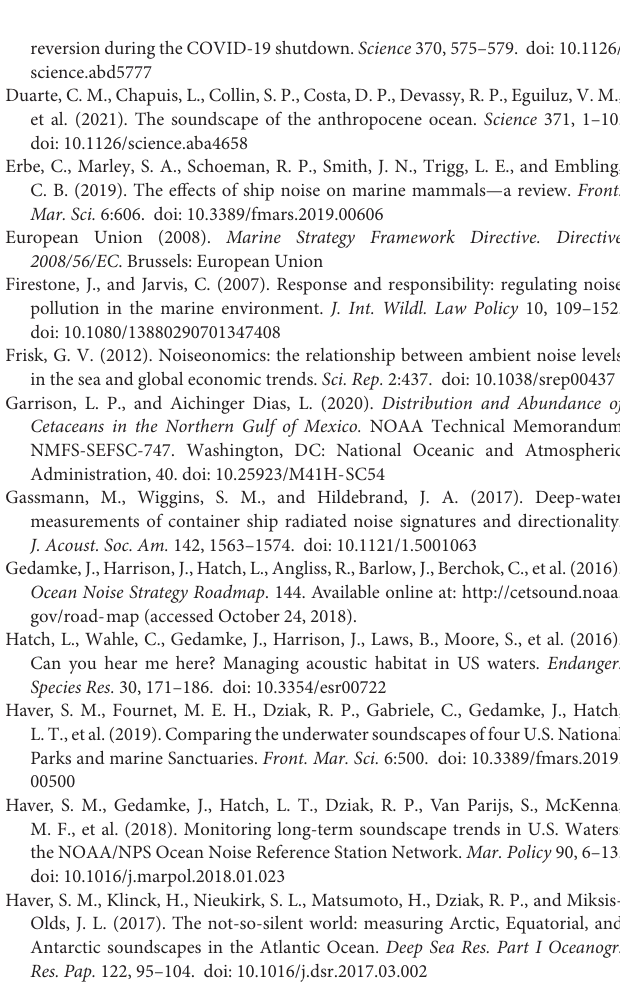
Supplementary Figure 1 | Scatter plot of both the 125 Hz (blue) and 63 Hz (orange) one-third octave frequency band (TOB) sound levels and the sum of cargo vessel transits from each of the five sites. Both 125 and 63 Hz TOB sound levels were positively correlated with number of cargo vessel transits. Supplementary Table 1 | Median, maximum, and minimum daily sound pressure levels (dB re 1 µ Pa) for both 63 Hz and 125 Hz one-third octave bands at each of the five sites during the 2016-2017 sampling time